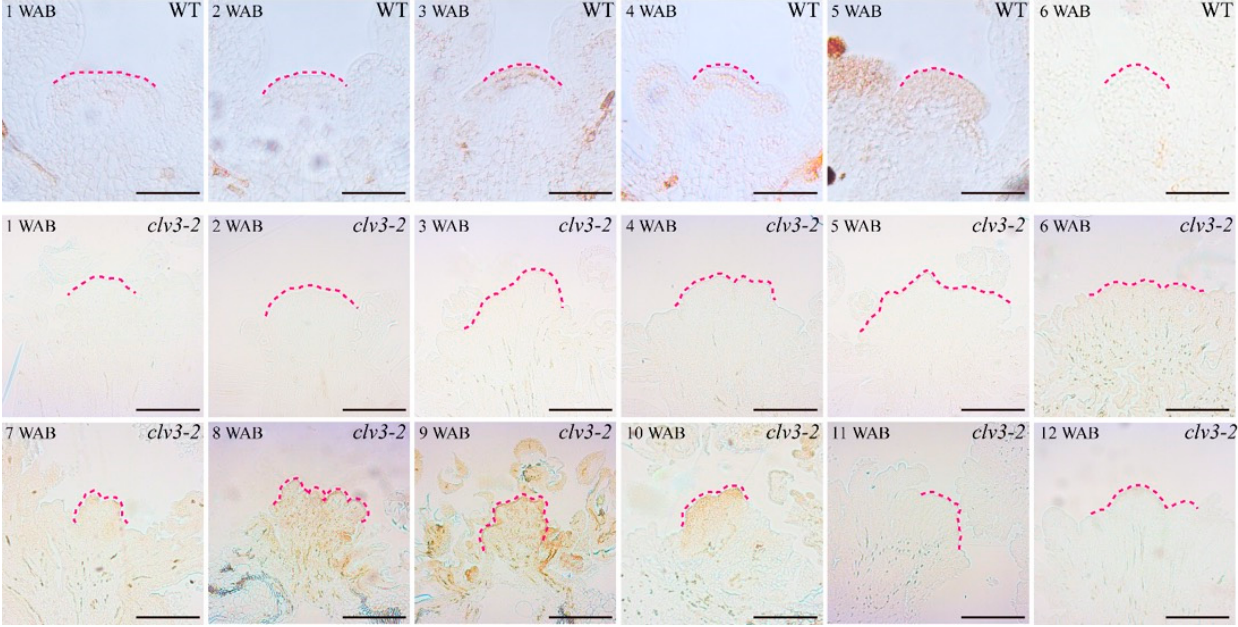
Figure 2. DAB staining of WT and clv3-2 IMs to demonstrate the H 2 O 2 signals (brown color). Dotted pink lines indicate the IM shape. Scale bars: 25 μ m in WT and 100 μ m in clv3-2 .